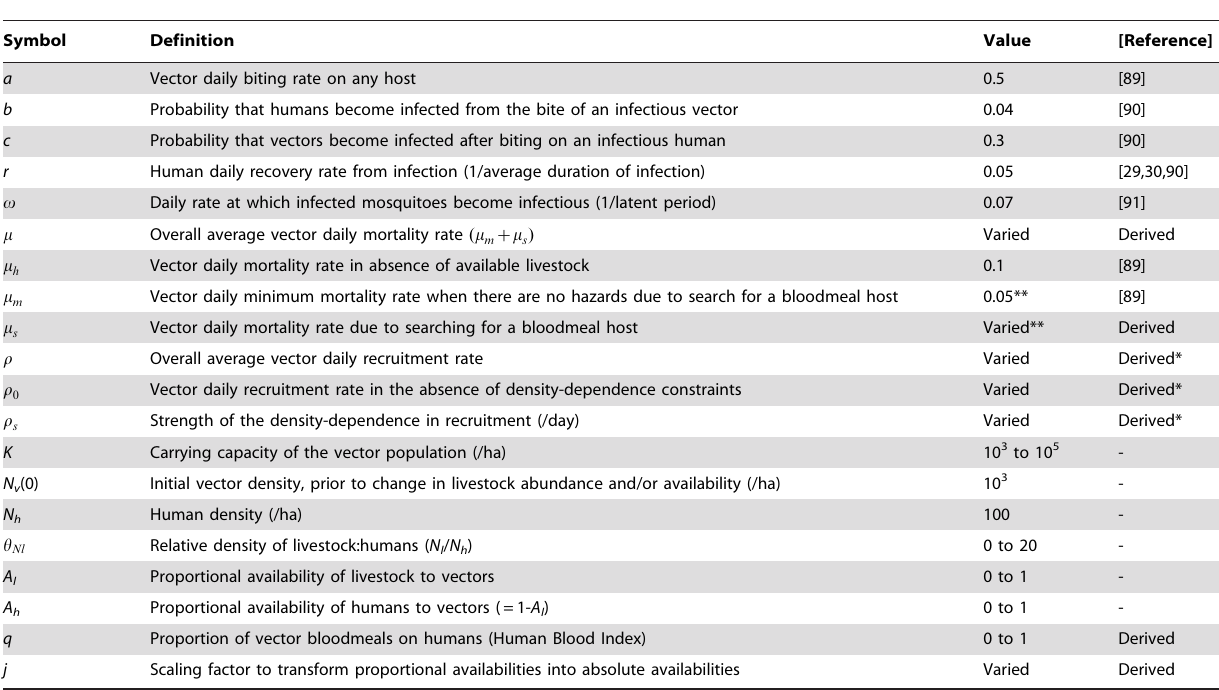
Table 1. Parameter values for modelling the effects of untreated livestock on malaria.